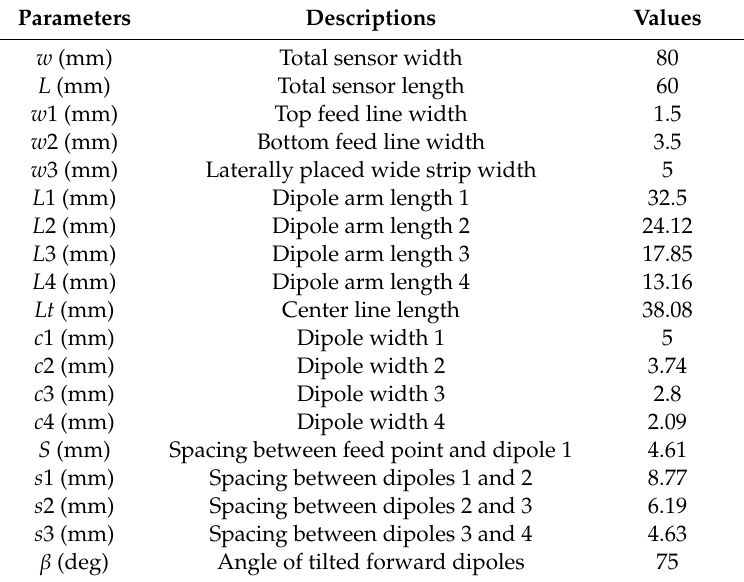
Table 1. Structural parameters of the proposed antenna sensor.